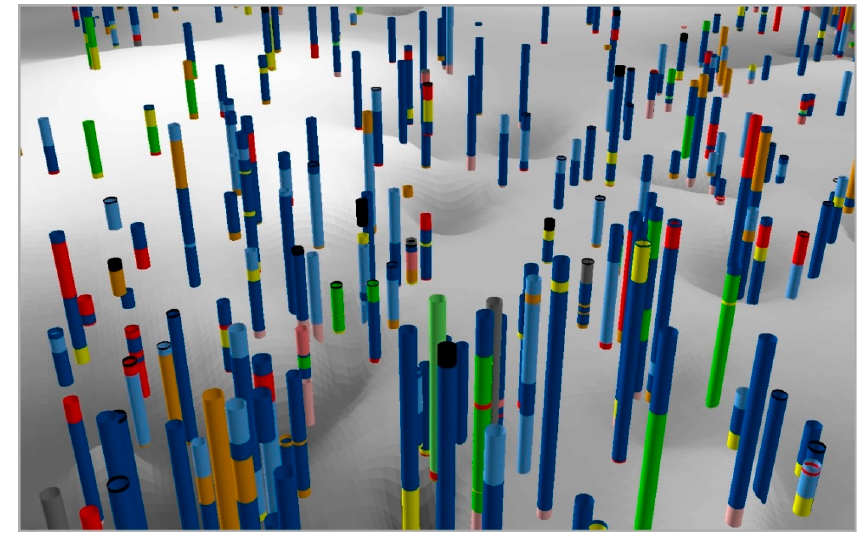
Figure 3. Perspective view of a sample of standardized 3D boreholes, which are 100 m in diameter. The grayscale background is the bedrock surface; light gray represents bedrock highs, dark gray represents bedrock lows.